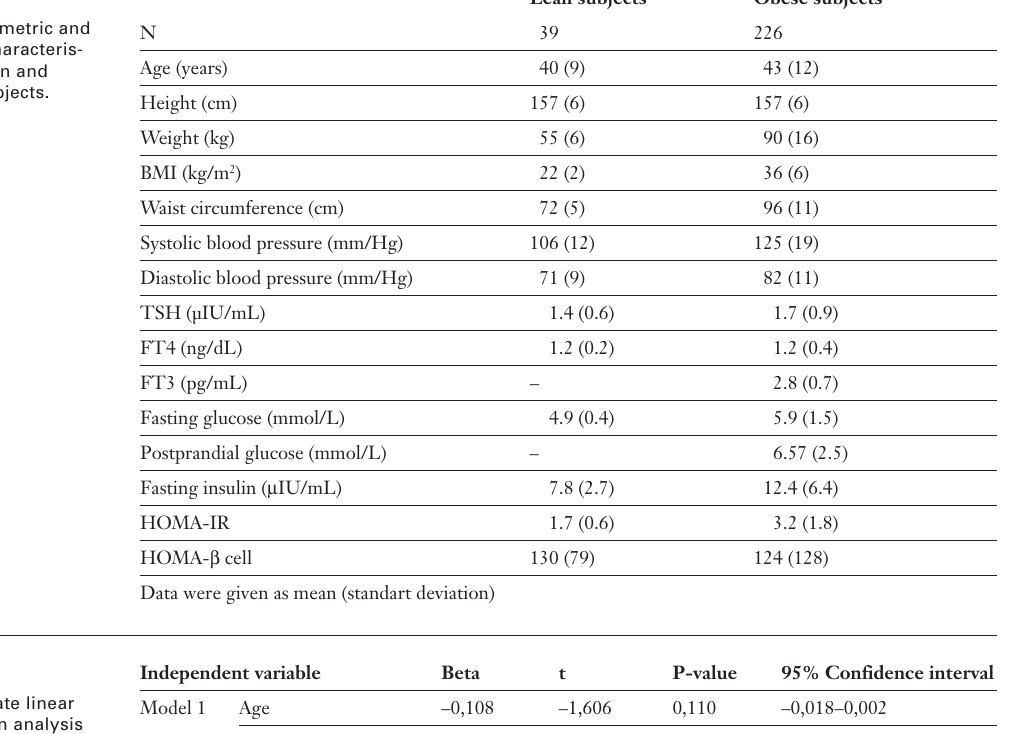
Multivariate linear regression analysis with TSH as depend- ent